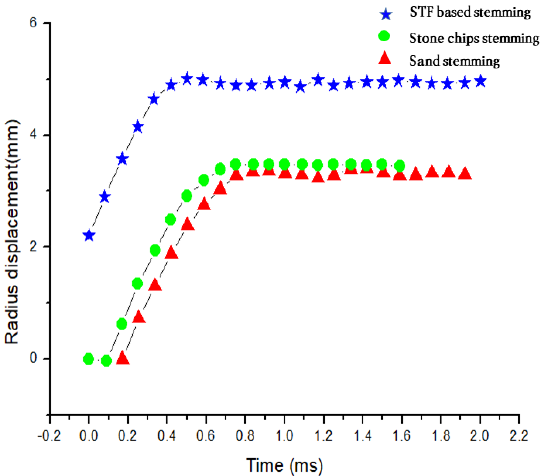
Figure 12. Sectional displacement of the lead block at the surface of the explosive chamber with initial setting time after detonation.